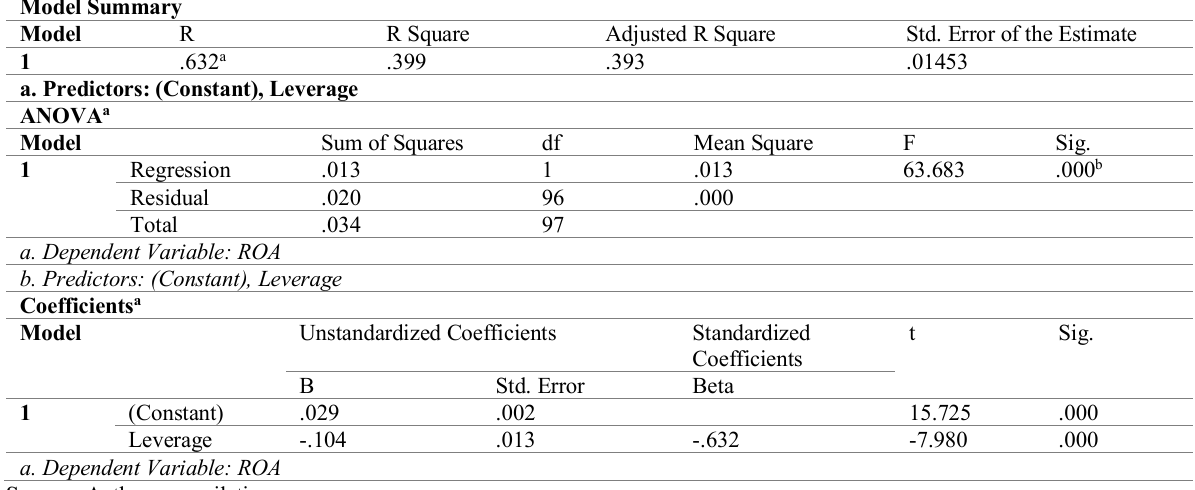
Table 7: Effect of Leverage on Financial Performance